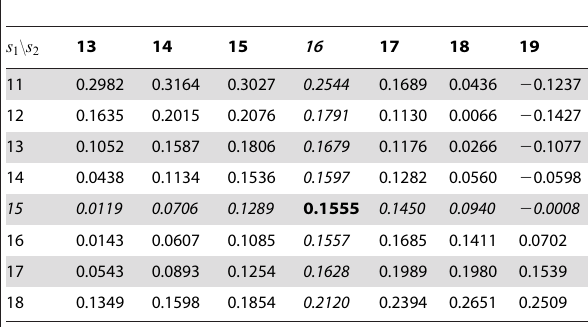
Table 1. Average bank payoff for our version of blackjack.